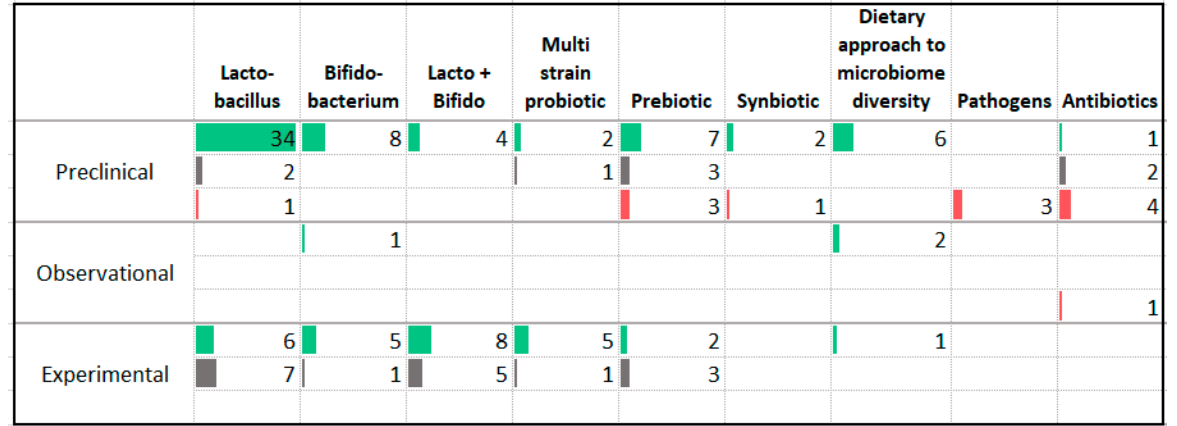
Figure 15. Studies assessing the microbiome and anxiety. █ Higher intake or levels associated with decreased anxiety. █ No association between intake or levels and anxiety. █ Higher intake or levels associated with increased anxiety.